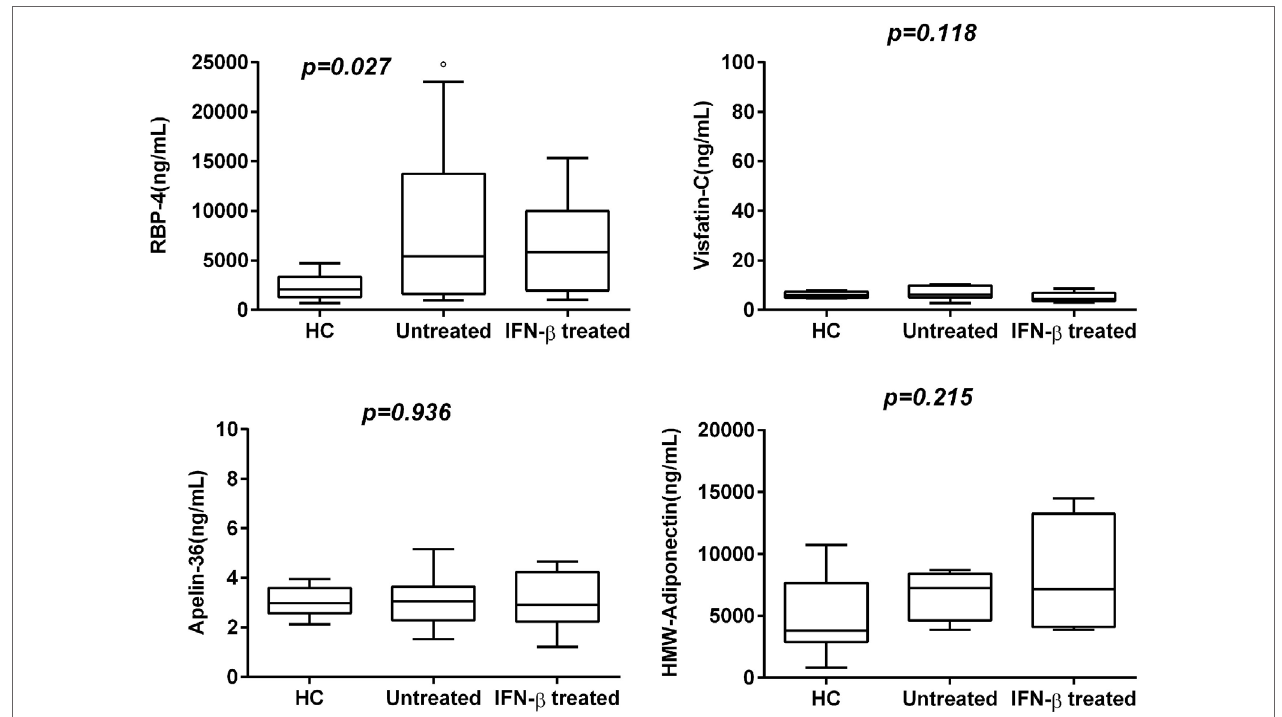
FigUre 3 | Box–whisker graphs of adipokine levels in the three study groups. Box–whisker plots show the 25th and 75th percentile range (box) with Tukey 95% confidence intervals (whiskers) and median values (transverse lines in the box). o p < 0.05 untreated vs healthy controls (HC). p -Value reported in figures are relative to Kruskal–Wallis H test.